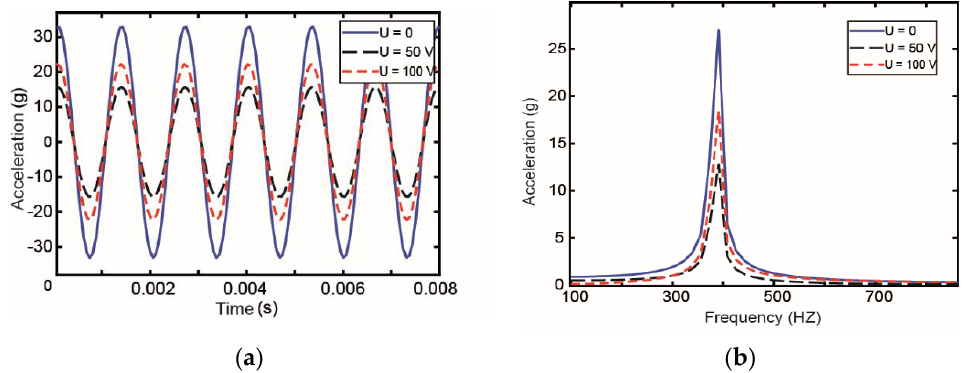
Figure 12. Vibration response in the ( a ) time domain and ( b ) frequency domain under different control voltages.